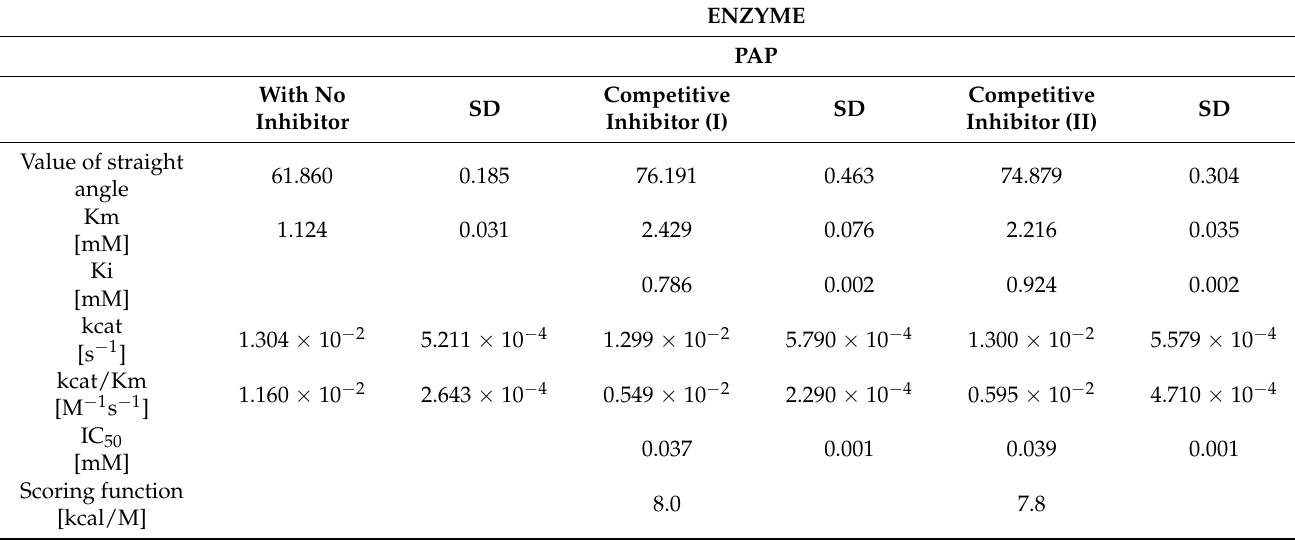
Table 3. Parameters characterizing the inhibitory strength of PAP and TNAP by compounds (I) and (II) (value of straight angle), the affinity strength of compounds (I) and (II) to both enzymes (Km and Ki values), catalytic constants (kcat), catalytic efficiencies (kcat/Km) and half-maximal inhibitory concentration (IC 50